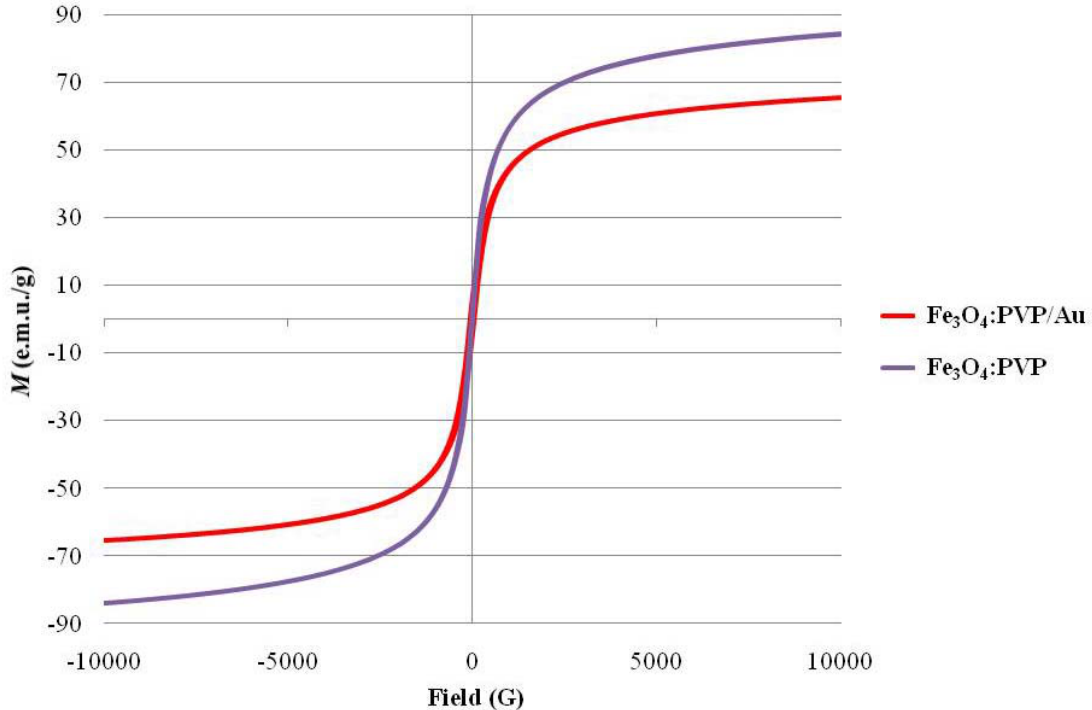
Figure 1. VSM data for the Fe conducted at